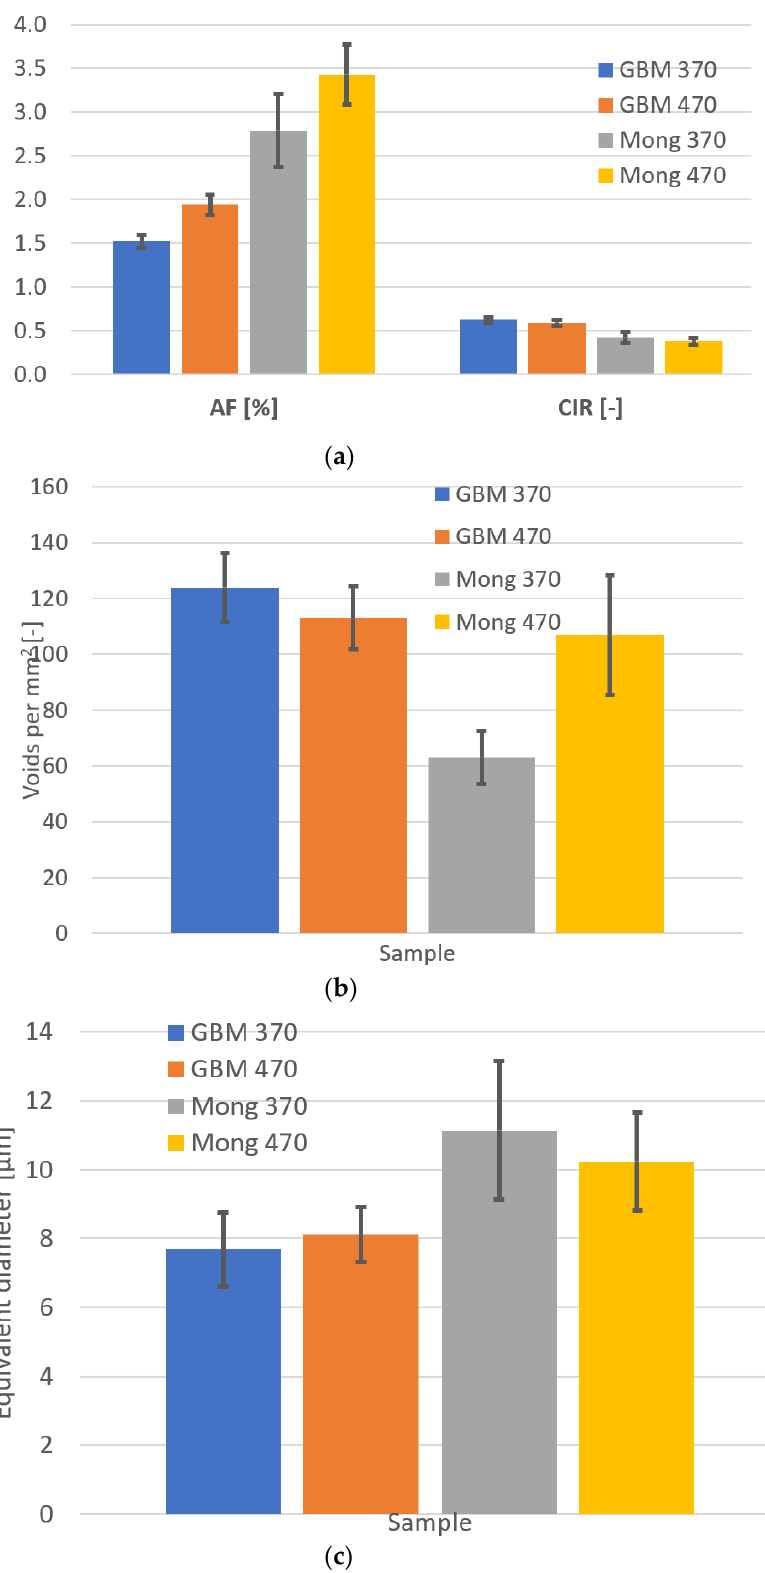
Figure 3. ( a ) . Porosity expressed as area fraction AF and circularity of pores CIR. ( b ) . Porosity Figure 3. ( a ) Porosity expressed as area fraction AF and circularity of pores CIR. ( b ) Porosity parameter Voids per mm 2 . ( c ) . Porosity parameter Equivalent diameter of a pore. parameter Voids per mm 2 . ( c ) Porosity parameter Equivalent diameter of a